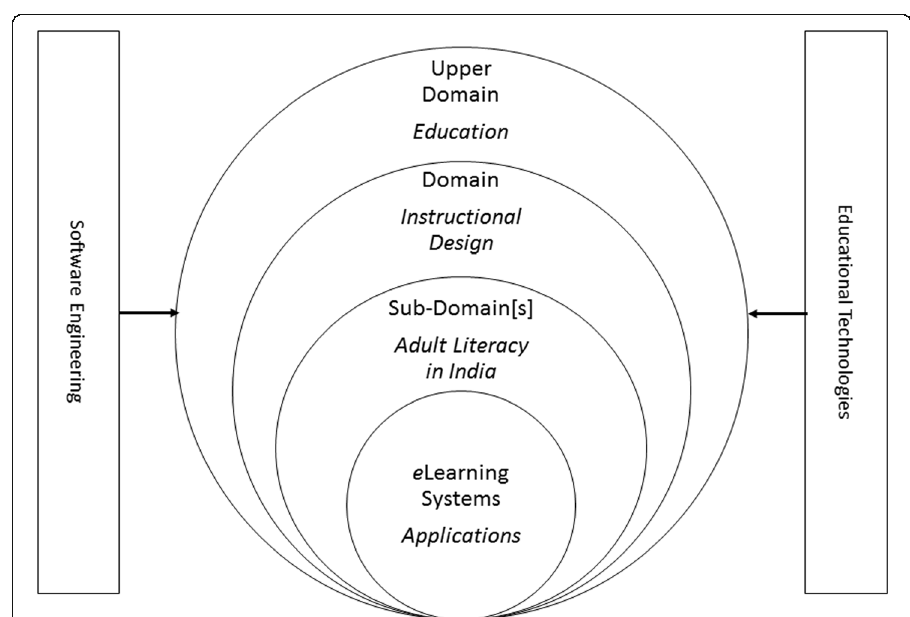
Fig. 2 Scope of Ontologies in this